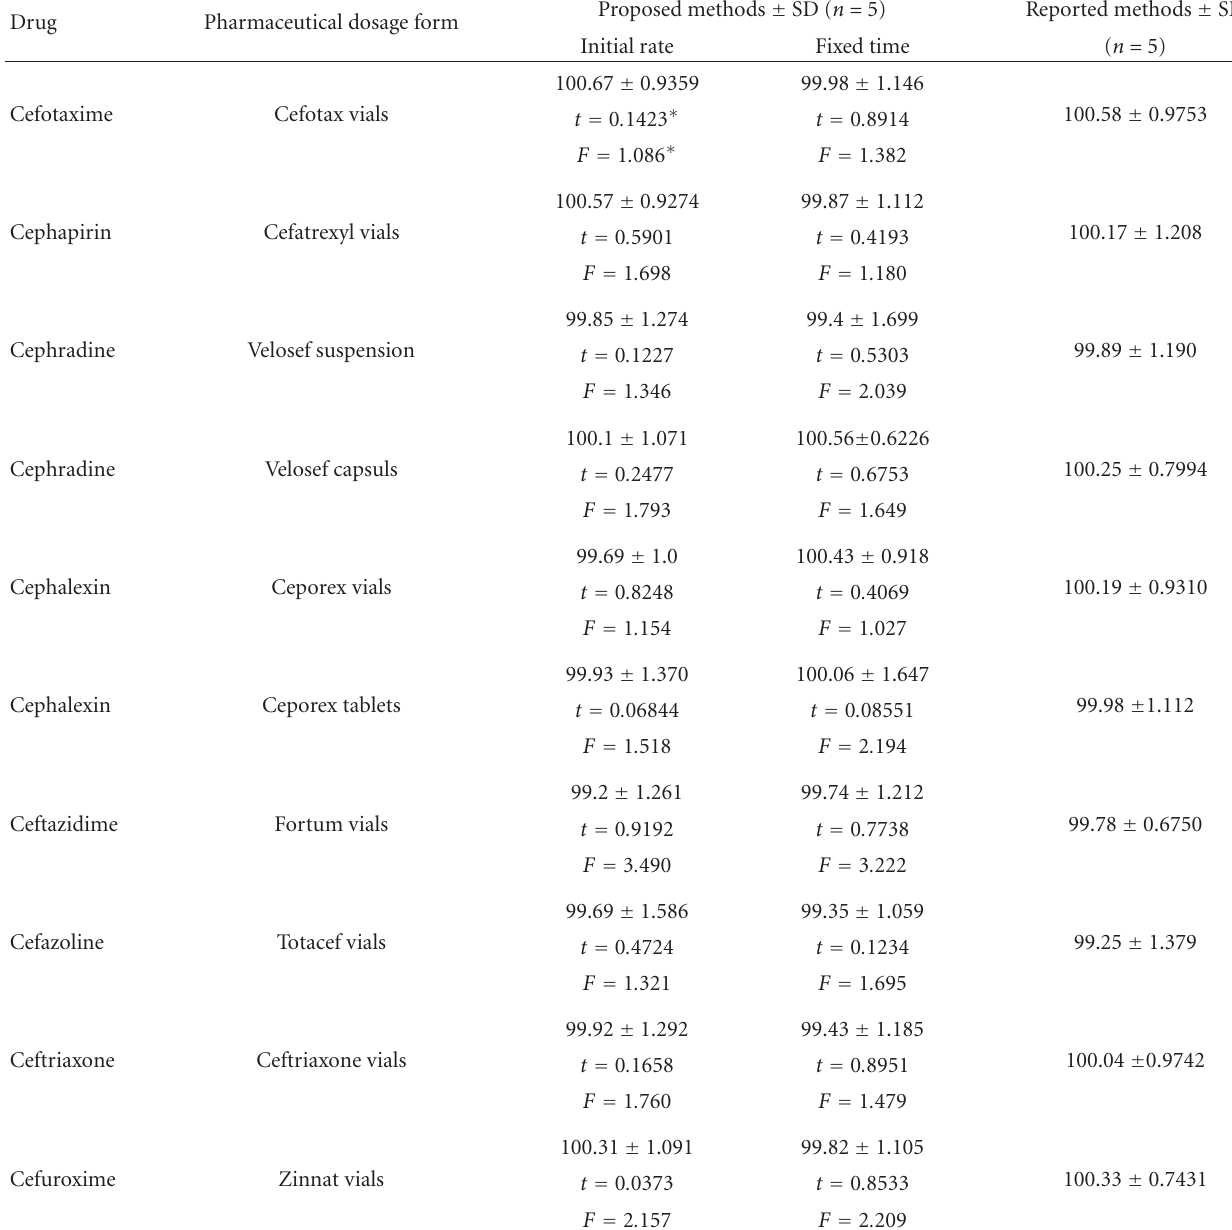
Table 7: Determination of studied drugs in their pharmaceutical dosage forms using initial rate and fixed time